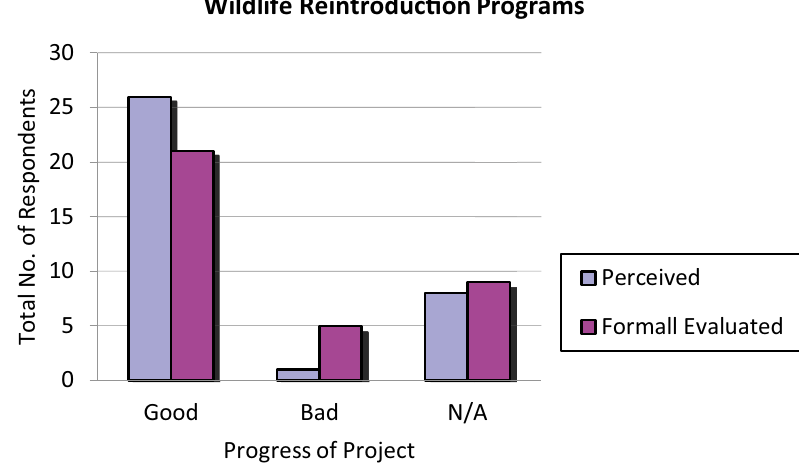
Figure 13. Self-assessed and evaluated progress in wildlife reintroduction